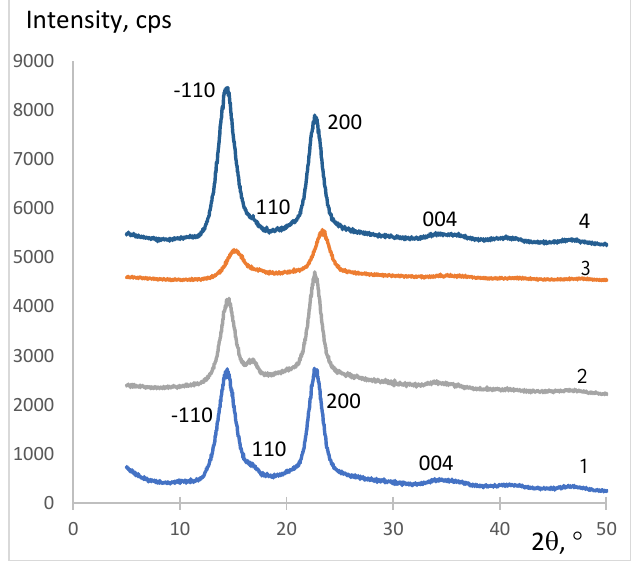
Figure2. X-raydi ff ractogramsofthebacterialcellulosecomposites: 1, BC;2, BC–HA–CS;3, BC–ALG–CS; Figure 2. X-ray diffractograms of the bacterial cellulose composites: 1, BC; 2, ВС–HA–CS; 3, ВС–ALG– 4, CS; 4, ВС–CAR–CS.